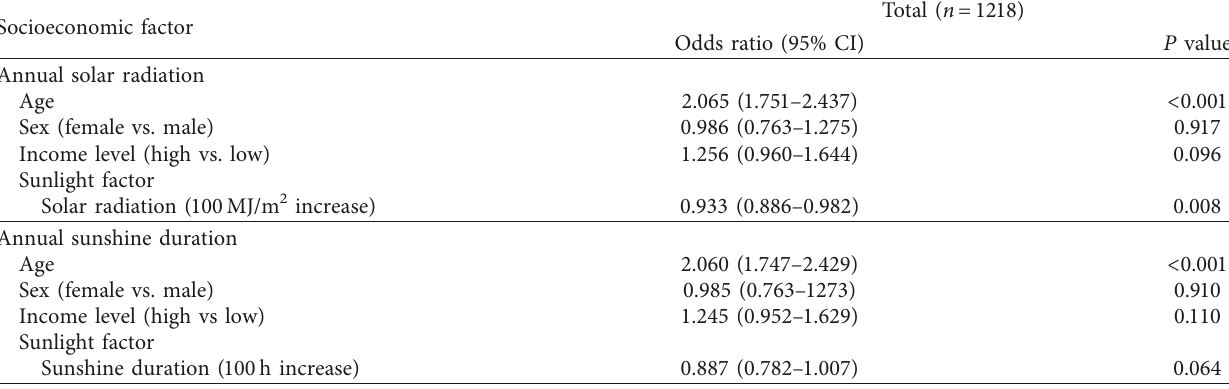
Table 3: Multiple logistic regression analysis to assess the associations of different variables with myopia